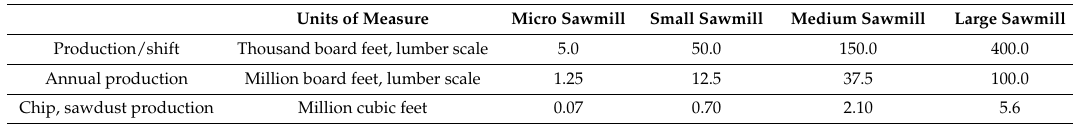
Table 1. Raw material requirements for different lumber production scenarios, ranging in size from micro to large